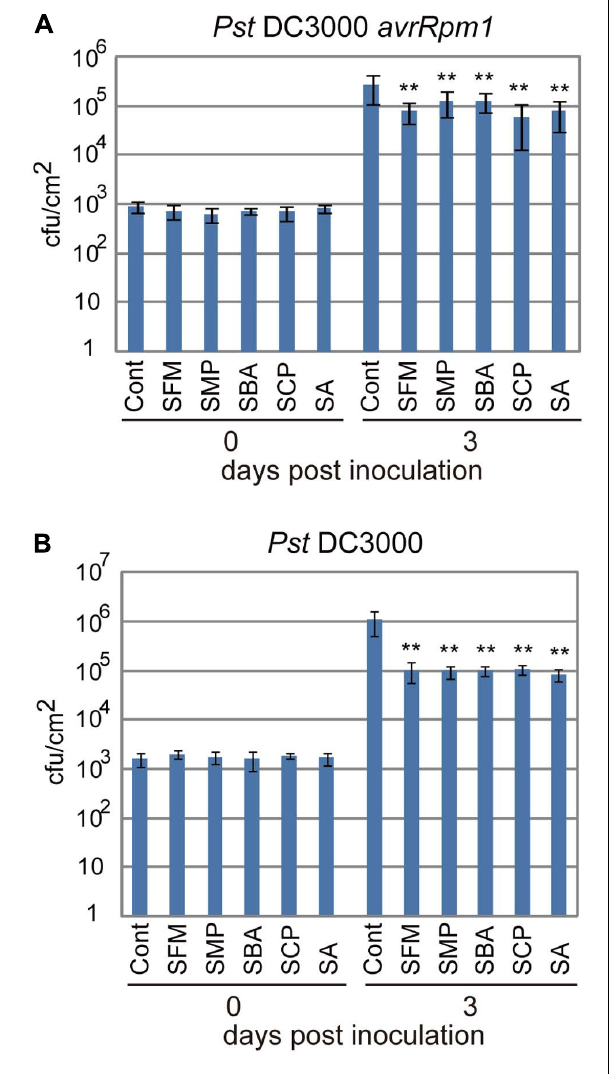
FIGURE 3 | Disease resistance of Arabidopsis plants treated with the sulfonamides. Arabidopsis plants grown on rockwool for 3 weeks under short-day conditions were drenched for 3 days with water supplemented with 100 μ M of each compound. As a positive control, 50 μ M of sodium salicylate (SA) was used.Then, the avirulent Pst-avrRpm1 (A) and the virulent Pst (B) were inoculated into leaves by infiltration with needle-less syringes (OD 600 = 0.002 in 10 mM MgCl 2 ) and bacterial counts inside leaves were counted at 0 and 3 days after inoculation.The error bars represent mean ± SE values ( n = 7). * P < 0.01; two-tailed Student’s t test. These data are representative of two independent replicates with similar results.